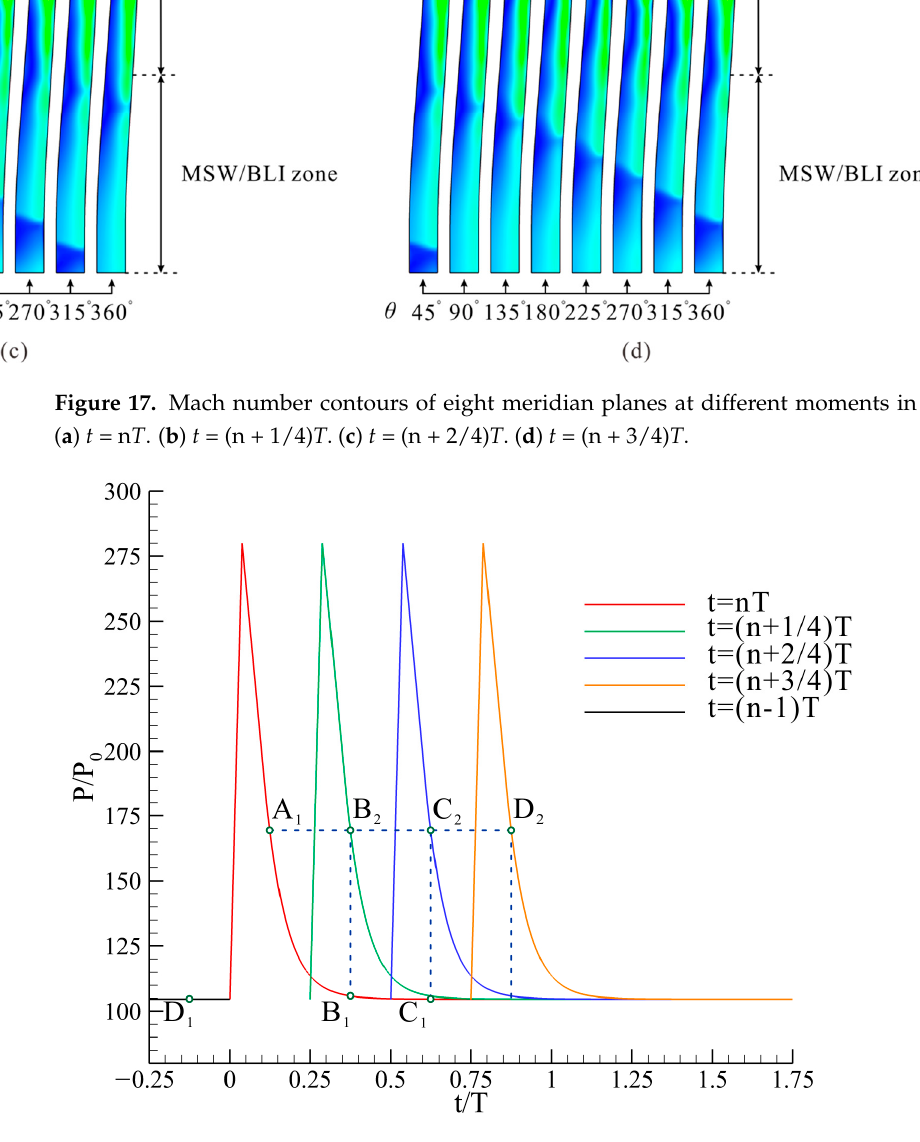
Figure 19. Mach number and pressure profiles of corresponding meridian planes at different mo- ments in one period. Based on the preceding discussions, we can draw the conclusion that the flow-field of the isolator under rotating feedback pressure perturbations is similar during the stable operating stage, which indicates that the rotation angular velocity of the TSW and the MSWs are equal and hold invariant, building the key foundation for the theoretical model of the inclination angle of the MSWs through velocity decomposition, previously men- tioned in Section 6.